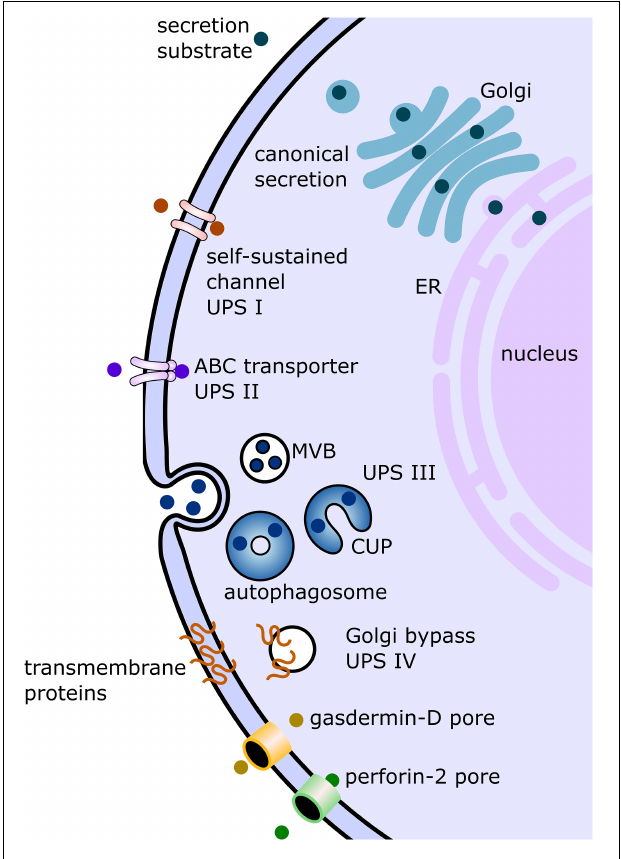
FIGURE 1 | Displayed are the canonical conventional as well as unconventional secretion pathways described in studies on mammalian cells and/or studies on protist parasites. In the conventional canonical secretion pathway, the secreted substrate passes through the endoplasmic reticulum (ER) to the Golgi apparatus (Golgi) and then to the plasma membrane via vesicular carriers. Several non-canonical pathways have been discovered